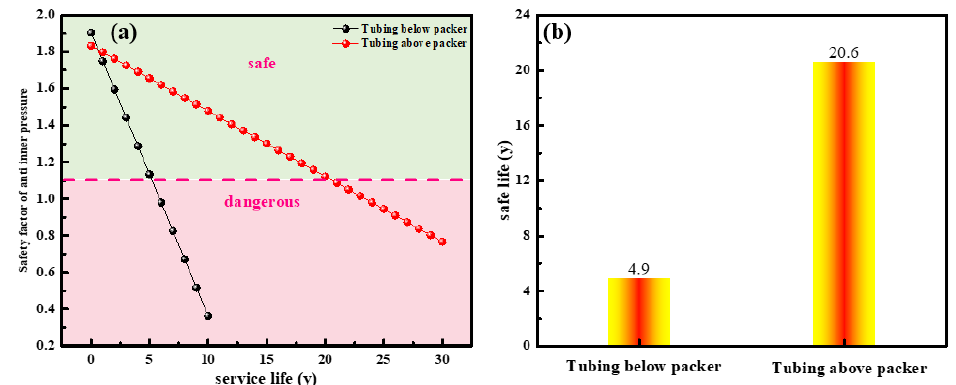
Figure 13. Safety factor of anti-inner pressure ( a ) and service life ( b ) of tubing.